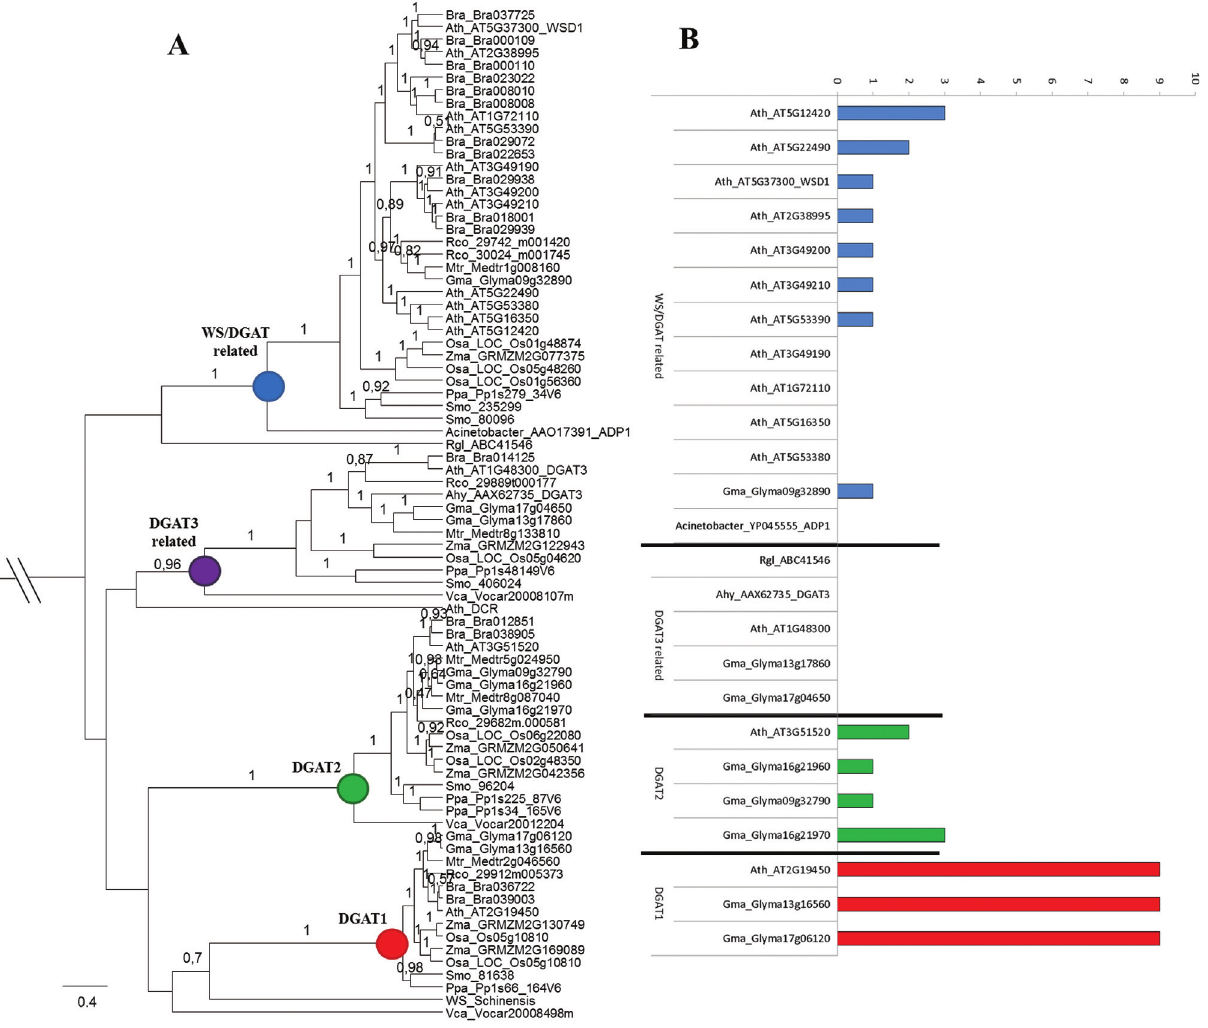
Figure 1 - Phylogenetic relationship among plant DGAT1, DGAT2, DGAT3 and WS/DGAT protein sequences. (A) The phylogenetic analysis was per- formed with DGAT protein sequences from Glycine max (Gma), Arabidopsis thaliana (Ath), Brassica rapa (Bra), Ricinus communis (Rco) , Medicago truncatula (Mtr), Arachis hypogaea (Ahy), Oryza sativa (Osa), Zea mays (Zma), Selaginella moellendorffii (Smo) , Physcomitrella patens and Volvox carteri (Vca). The DCR (AT5G23940) from A. thaliana , WS (AAD38041) from Simmondsia chinensis , the DGAT3 (ABC41546) from Rhodotorula glutinis and WS/DGAT (YP045555) from Acinetobacter sp. were also included in the analysis. The posteriori probabilities are labeled above the branches. Only values higher than 0.5 are presented. (B) Predicted transmembrane domain for DGAT1, DGAT2, DGAT3 and WS/DGAT from A. thaliana (Ath) and G. max (Gma). The WS/DGAT from Acinetobacter sp. and DGAT3 from R. glutinis and A. hypogaea were also analyzed. TMHMM webtoolsoftheCenterforBiologicalSequenceAnalysis,TechnicalUniversityofDenmarkTMHMMServerplotsshowingtheprobabilityoftheALDH sequence forming a transmembrane helix (0-1.0 on the y-axis) (shown in red for the relevant amino acid